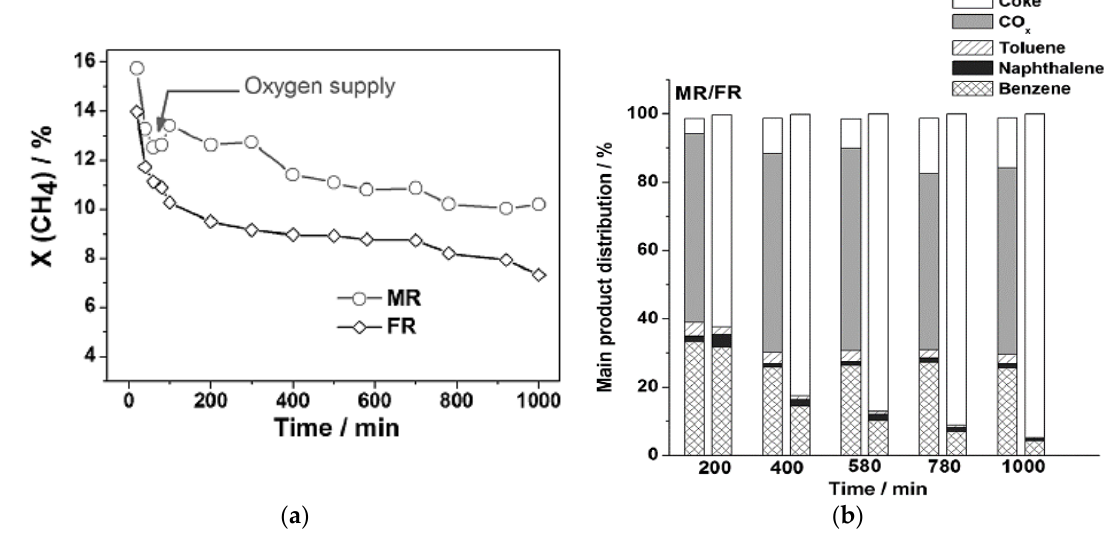
Figure 4. Methane conversion over time for ( a ) membrane reactor (MR) and fixed-bed reactor (FR) and ( b ) Product selectivity [31]. Copyright 2013 Wiley.